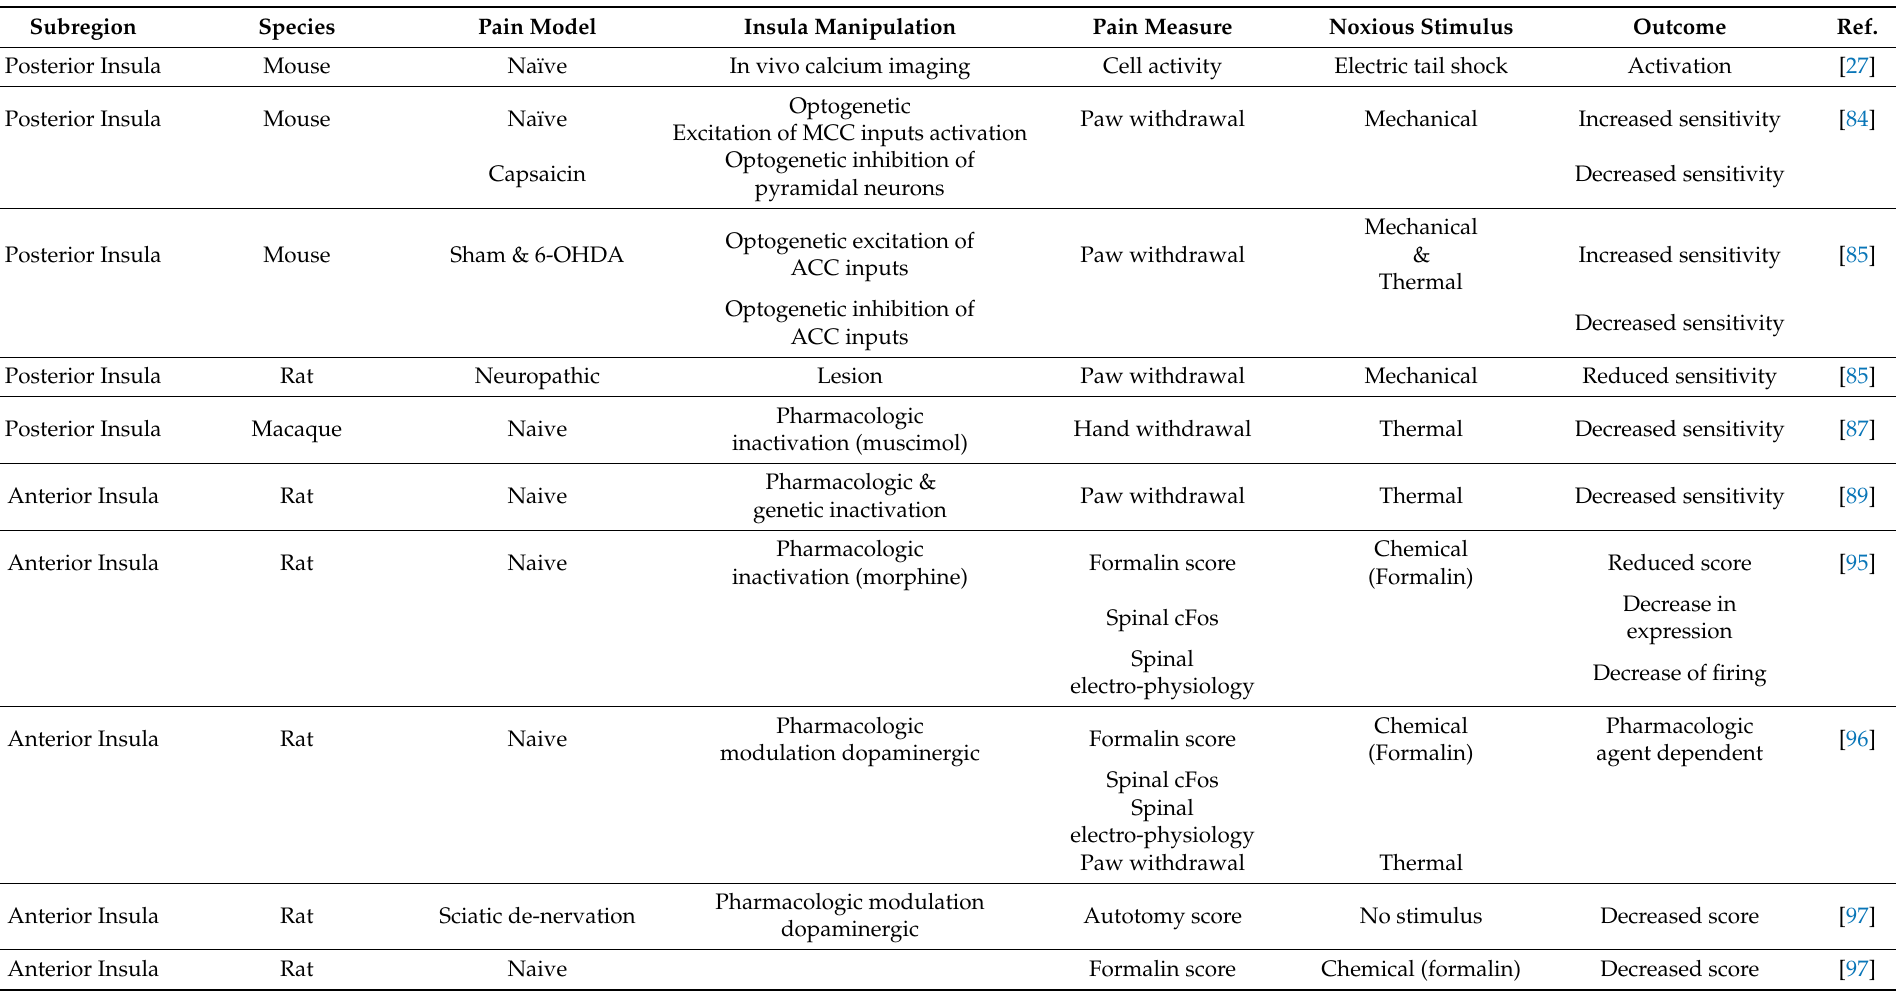
Table 2. Overview of pre-clinical studies on the role of the insula in